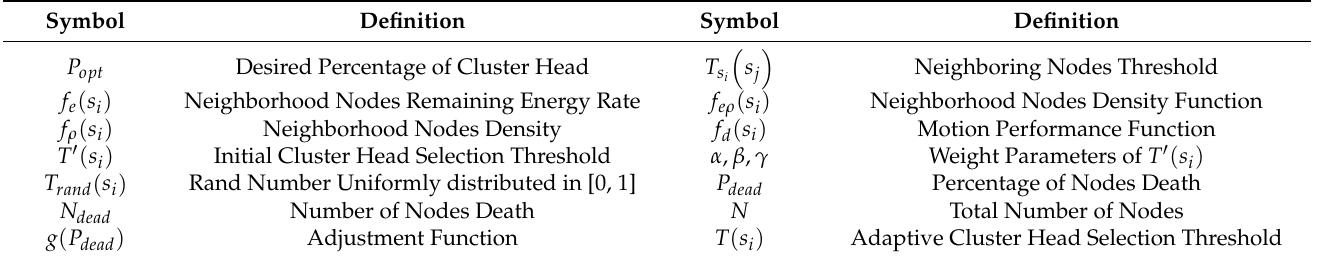
Table 1. Symbolic representation in adaptive cluster head selection threshold construction